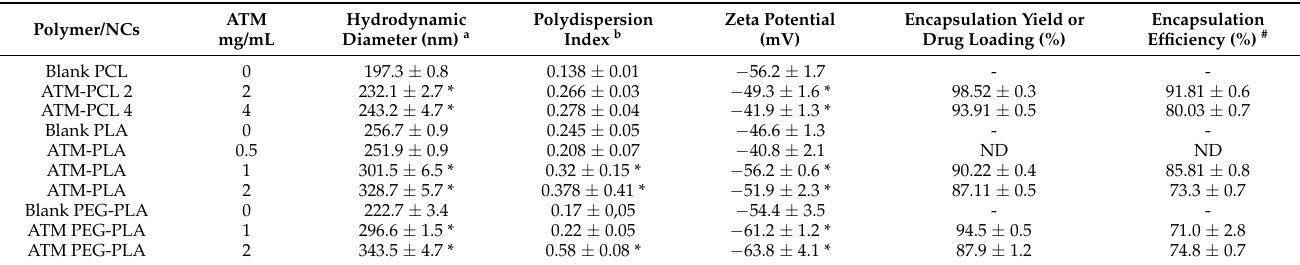
Table 1. Characterization of the artemether-loaded